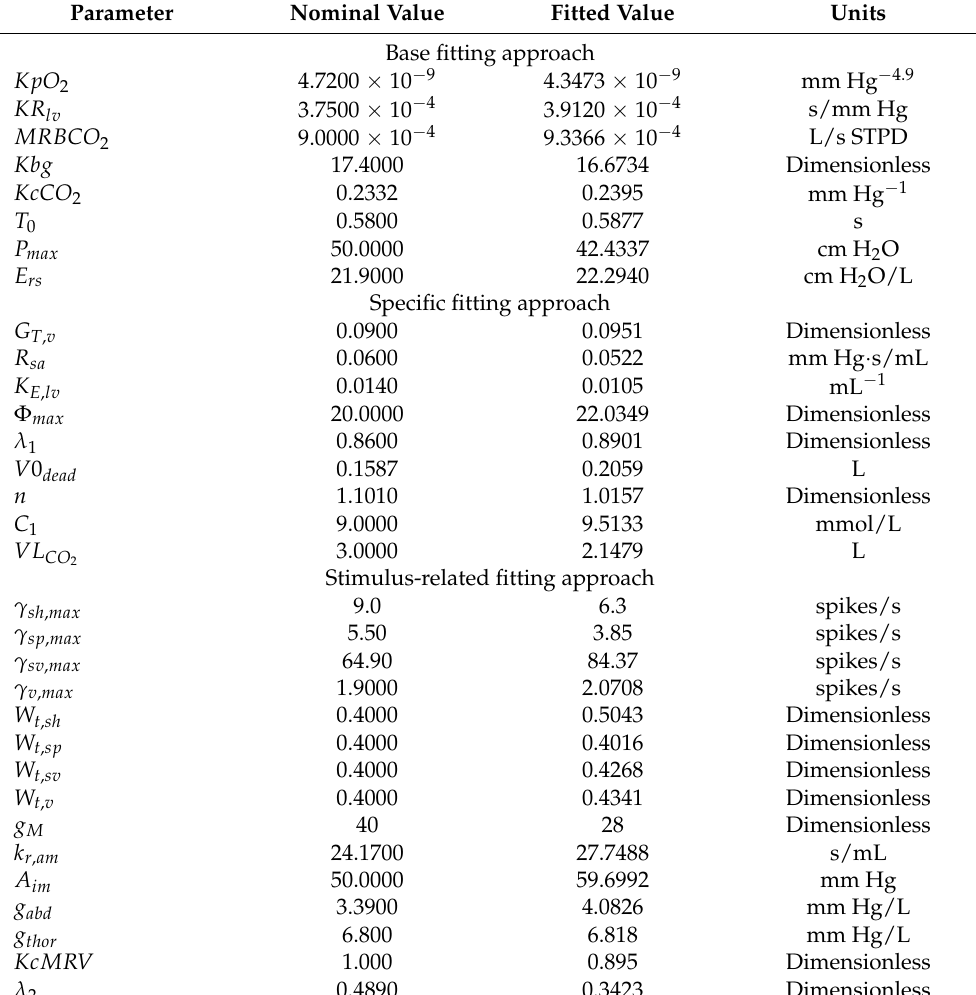
Table 5. Comparison of the parameter nominal values and optimization results for each fitting